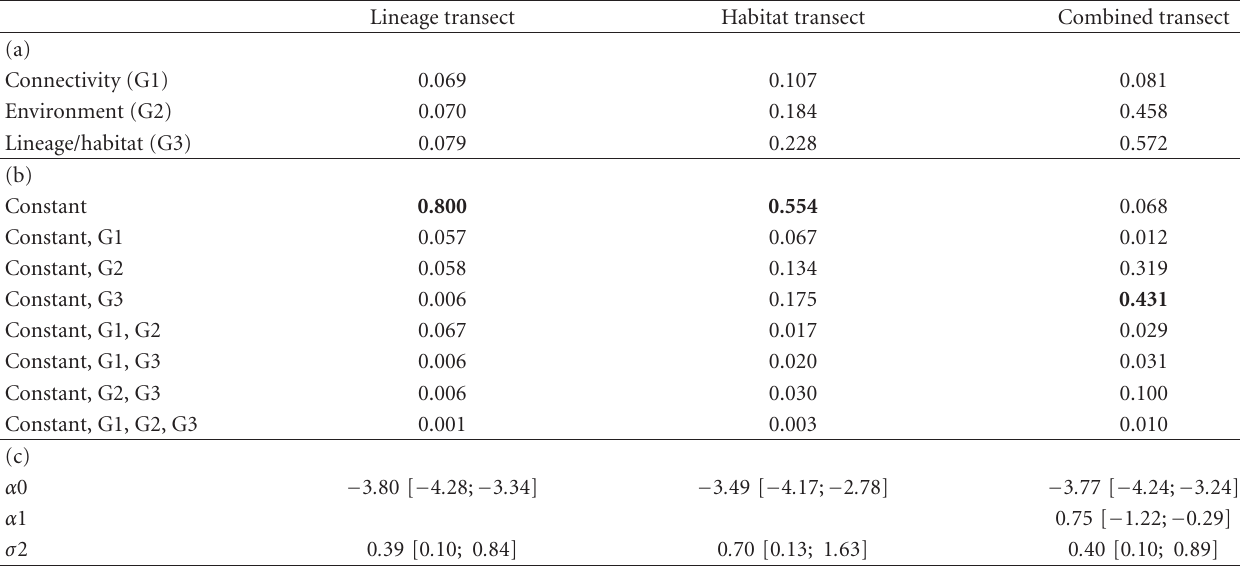
Table 2: Environmental factors determining the genetic structure of populations. (a) Sum of posterior probabilities of models including a given factor. (b) Posterior probability of the 8 models considered. The best model is indicated in bold. (c) Estimates of the regression parameters for the best model (mean value and lower and upper limits of the 95% highest probability density interval are